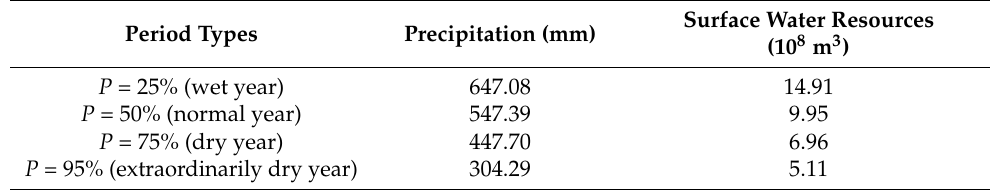
Table 1. Predicted results of precipitation in Beijing in